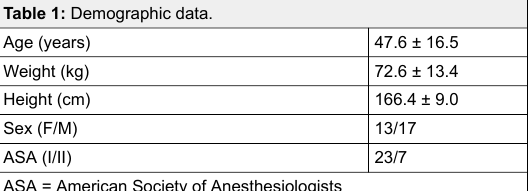
Table 1: Demographic data.